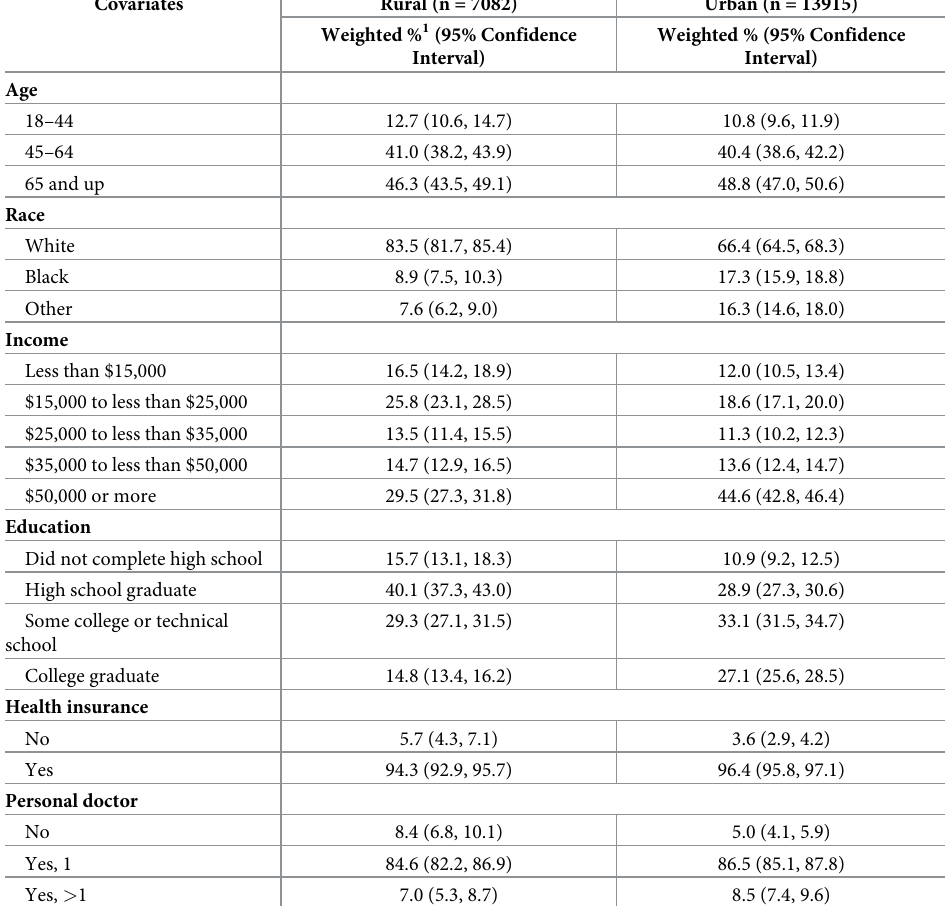
Table 1. Characteristics of women with prediabetes participating in the 2016–2020 Behavioral Risk Factor Sur- veillance System (BRFSS)